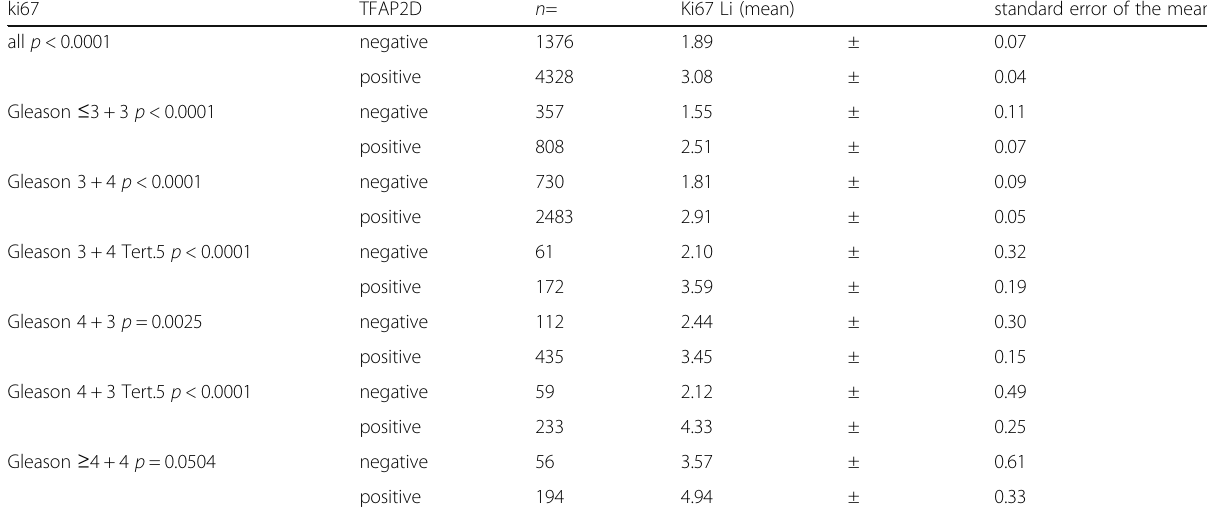
Table 3 TFAP2D immunostaining and Ki67 labeling index